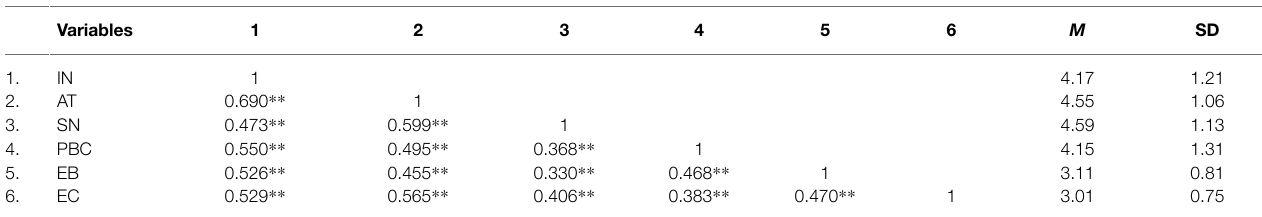
TABLE 1 | Descriptive statistics and Pearson correlation between the variables in the extended TPB model ( n = 581).